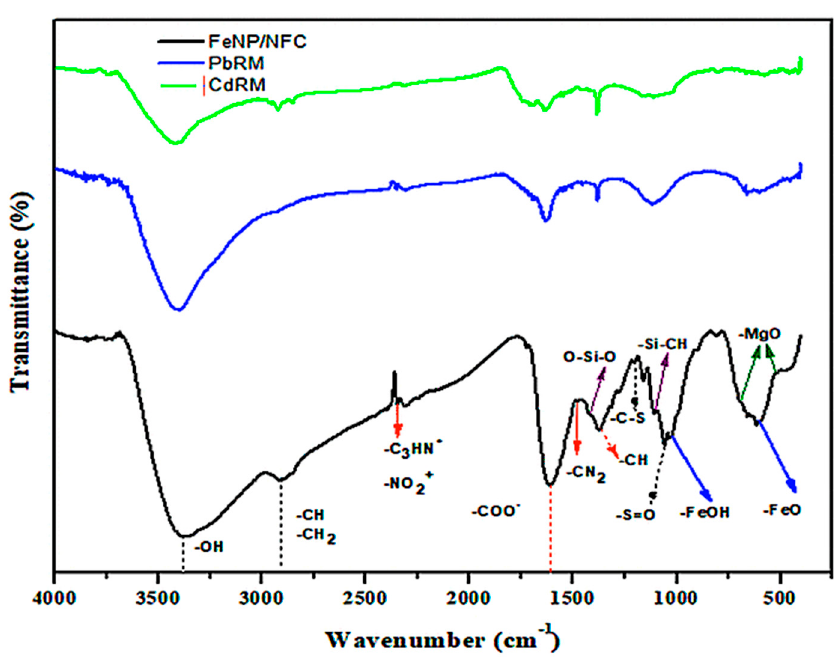
Figure 5. FTIR spectra of FeNP/NFC, adsorbent after Pb adsorption (PbRM) and after Cd adsorption (CdRM).